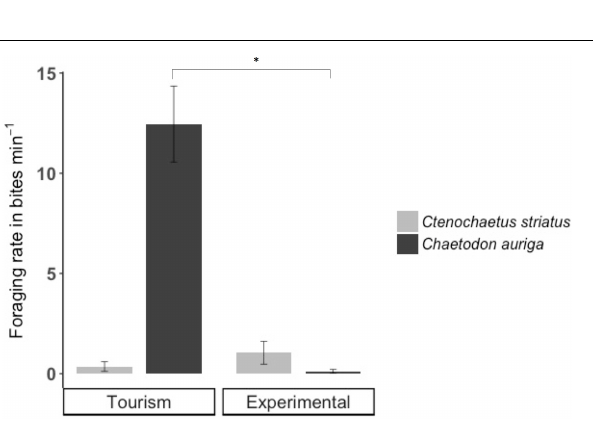
FIGURE 5 | Foraging rate ( ± SE) of Ctenochaetus striatus (A ) and Chaetodon auriga (B) on natural food at tourism and experimental bread feeding sites before, during and after bread feeding events. Note that the scale of y axes differs and significant differences are indicated by asterisks.